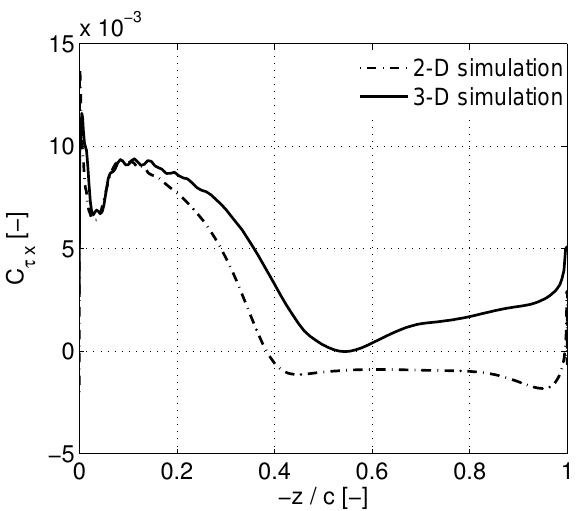
Figure 13. Wall shear stress in the chordwise direction over the suction side for the 2-D and 3-D ( r = 0 . 26 R )